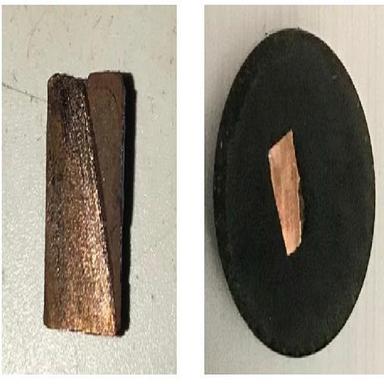
Sectional view of FGM.